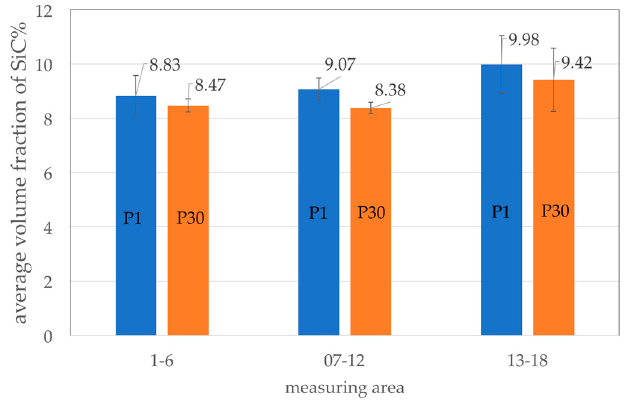
Figure 7. Distribution of the SiC particles in the semi-finished piston: P1—1st cast, P30—30th cast.